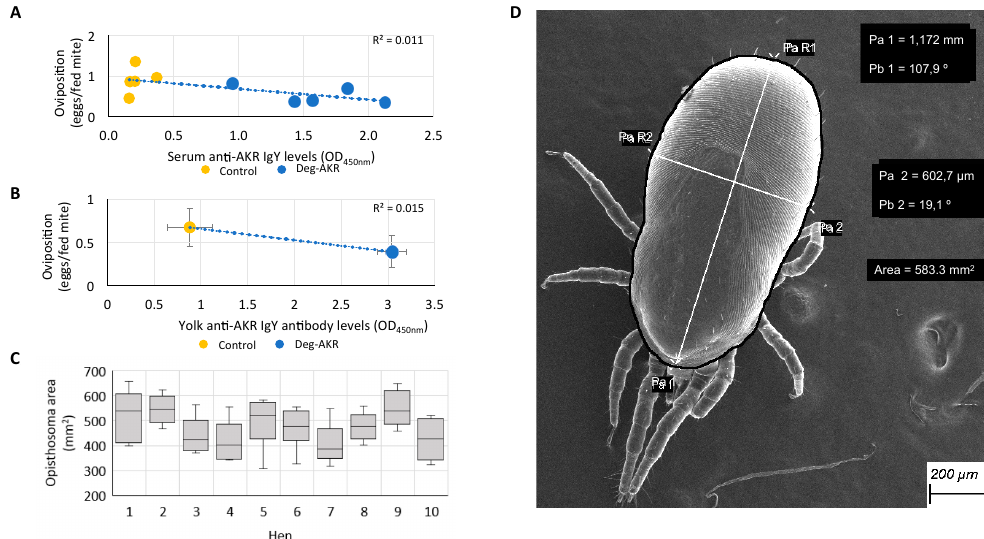
Figure 4. Effect of hen vaccination on PRM oviposition. Antibody levels negatively correlate with the number of eggs laid per fed mite. ( A ) Negative correlation between the levels of serum anti-Deg-AKR IgY and mite oviposition (number of eggs laid per fed adult female mite during the four on-hen feeding tests performed on day 7 of mite monitorization) (r = − 0.106, p < 0.01). ( B ) Negative correlation between the levels of egg yolk anti-Deg-AKR IgY and mite oviposition (average number of eggs laid per fed adult female mite) (r = − 0.125, p < 0.01; N = nine egg samples per group with egg collection during 2 consecutive days on days 15–16 (T1), 29–30 (T2) and 42–43 (T3). ( C ) Opisthosoma area in fully engorged adult female mites using five to six mites per hen during the fourth on-hen feeding assay. ( D ) Measures taken for each individual mite to assess the body size after feeding. Mites were photographed with a field emission scanning electron microscope. Mite body length and width were measured, and body area calculated using a Fiji ImageJ Software